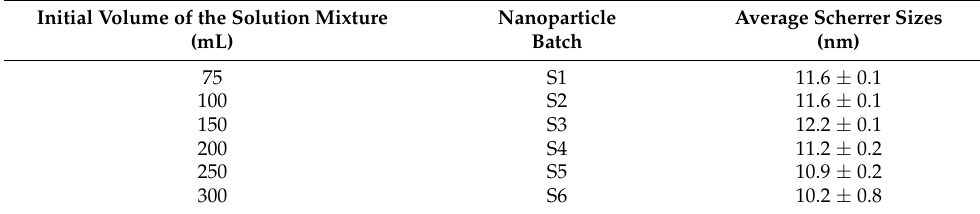
Figure 1. X-ray diffraction patterns of Fe 3 O 4 nanoparticles synthesized by using the different initial volumes of solution mixtures. The Scherrer average crystallite sizes for nanoparticles are shown above the respective XRD profile. Table 1. Average particle sizes obtained from XRD for nanoparticle batches synthesized using 75, 100, 150, 200, 250, and 300 mL of the initial volume of solution